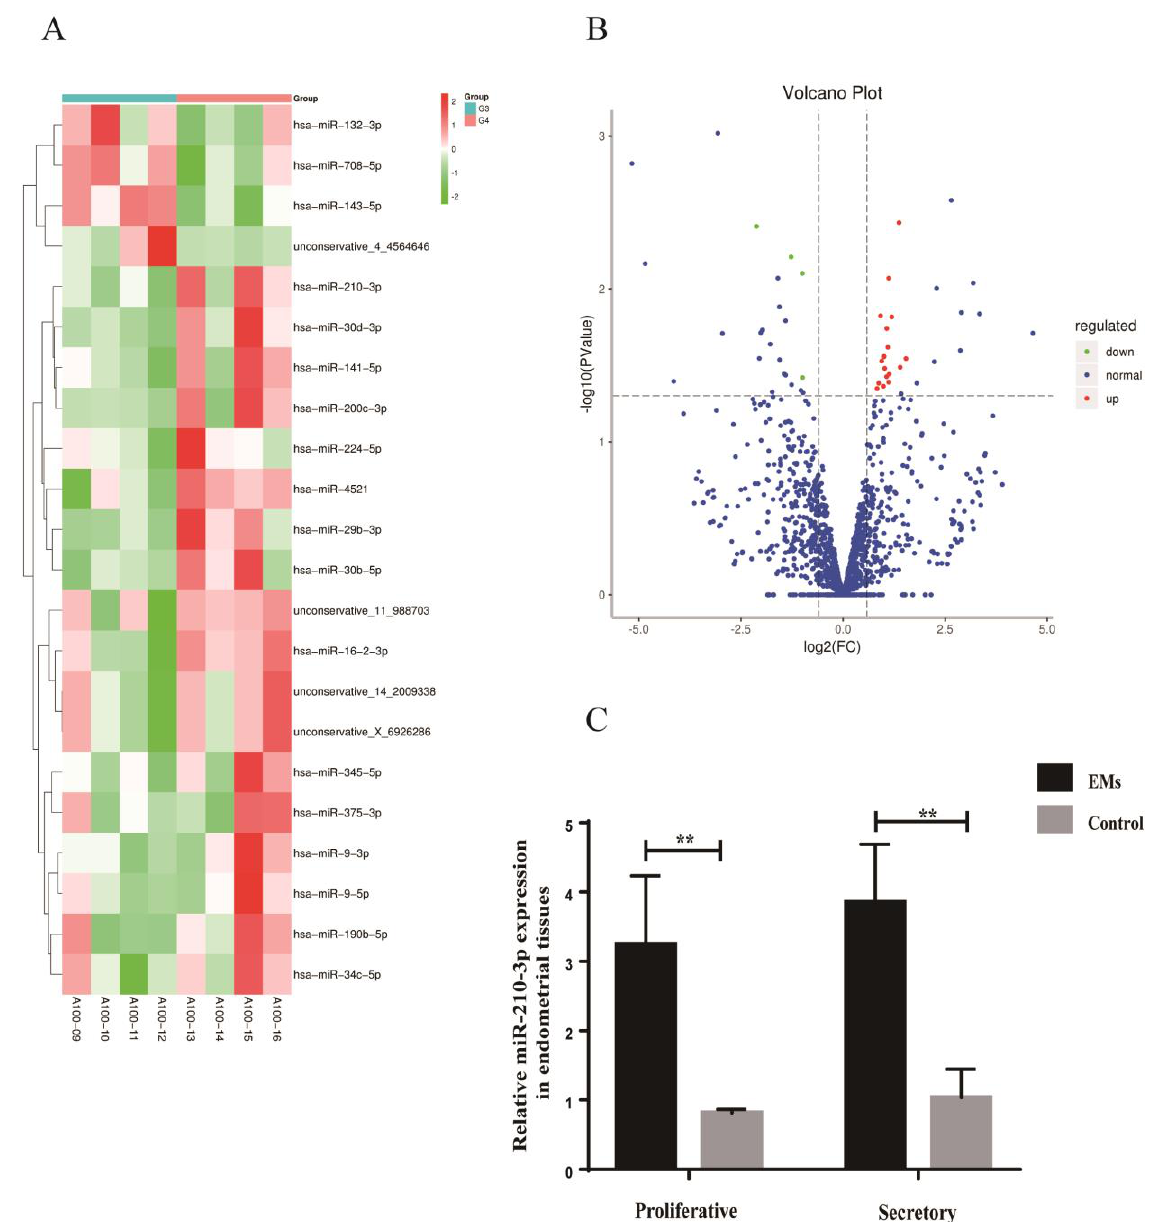
Figure 8. Differentially expressed miRNAs in endometrial tissues. ( A ) Heatmap of the differentially expressed miRNAs in endometrial tissues from patients with endometriosis compared with the control. ( B ) The Volcano plot of the differentially expressed miRNAs in endometrial tissues from patients with endometriosis compared with the control. The red color indicates increased expression while the green color indicates decreased expression. A100 − 09 to A100 − 12 were the control group; A100 − 13 to A100 − 16 were the EMs group. ( C ) RT-qPCR was used to verify the expression of miR- 210-3p in endometrial tissues from the EMs group and the control group. Data are expressed as the mean ± SEM (** p <